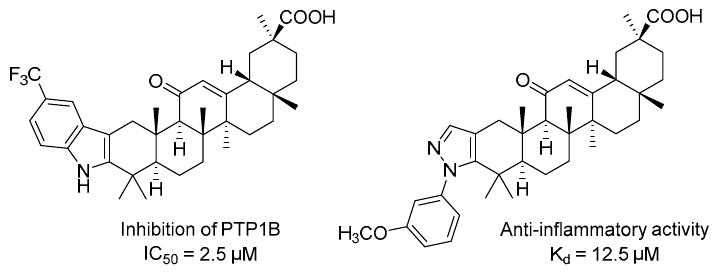
Figure 1. Heterocyclic derivatives of GA with biological activity